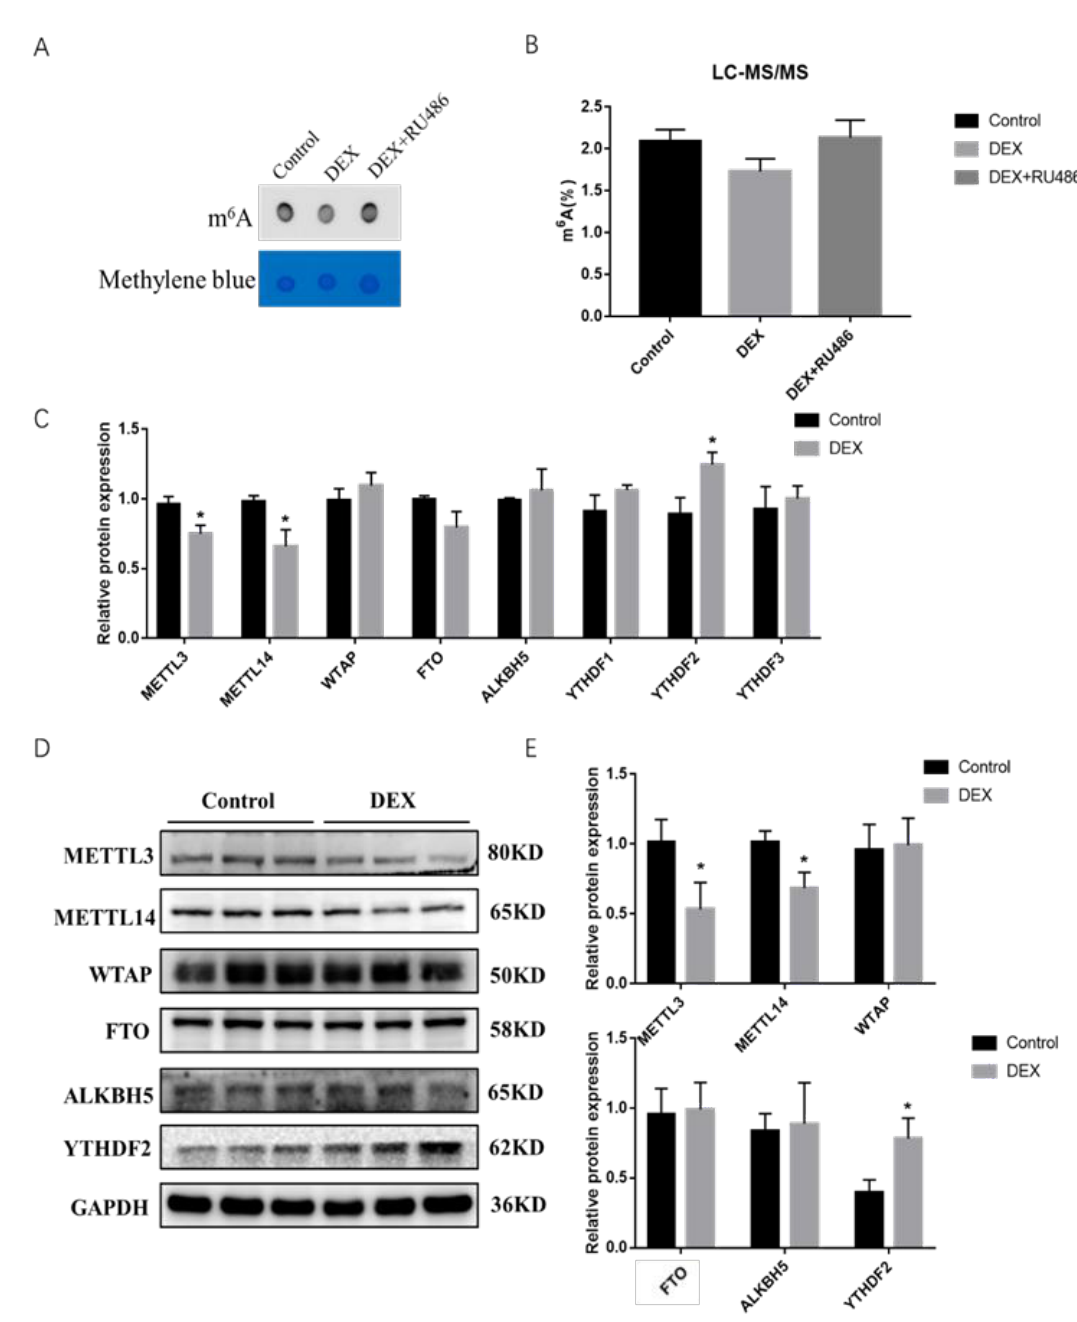
Figure 2. m 6 A modification level changes after DEX and RU486 treatment in porcine skeletal muscle cells. ( A ) Dot blot confirmed the m 6 A modification after DEX and RU486 treatment; ( B ) the m 6 A ratio in RNA was measured using LC-MS/MS; ( C ) the mRNA expression levels of METL3 , METL14 , WTAP , FTO , ALKBH5 and YTHDF1-3 after treatment with DEX; ( D ) protein expression levels of METTL3, METTL14, WTAP, FTO and YTHDF2 after treatment with DEX; ( E ) quantification of Western blotting under the treatment of DEX. * Indicates a significant difference at p <